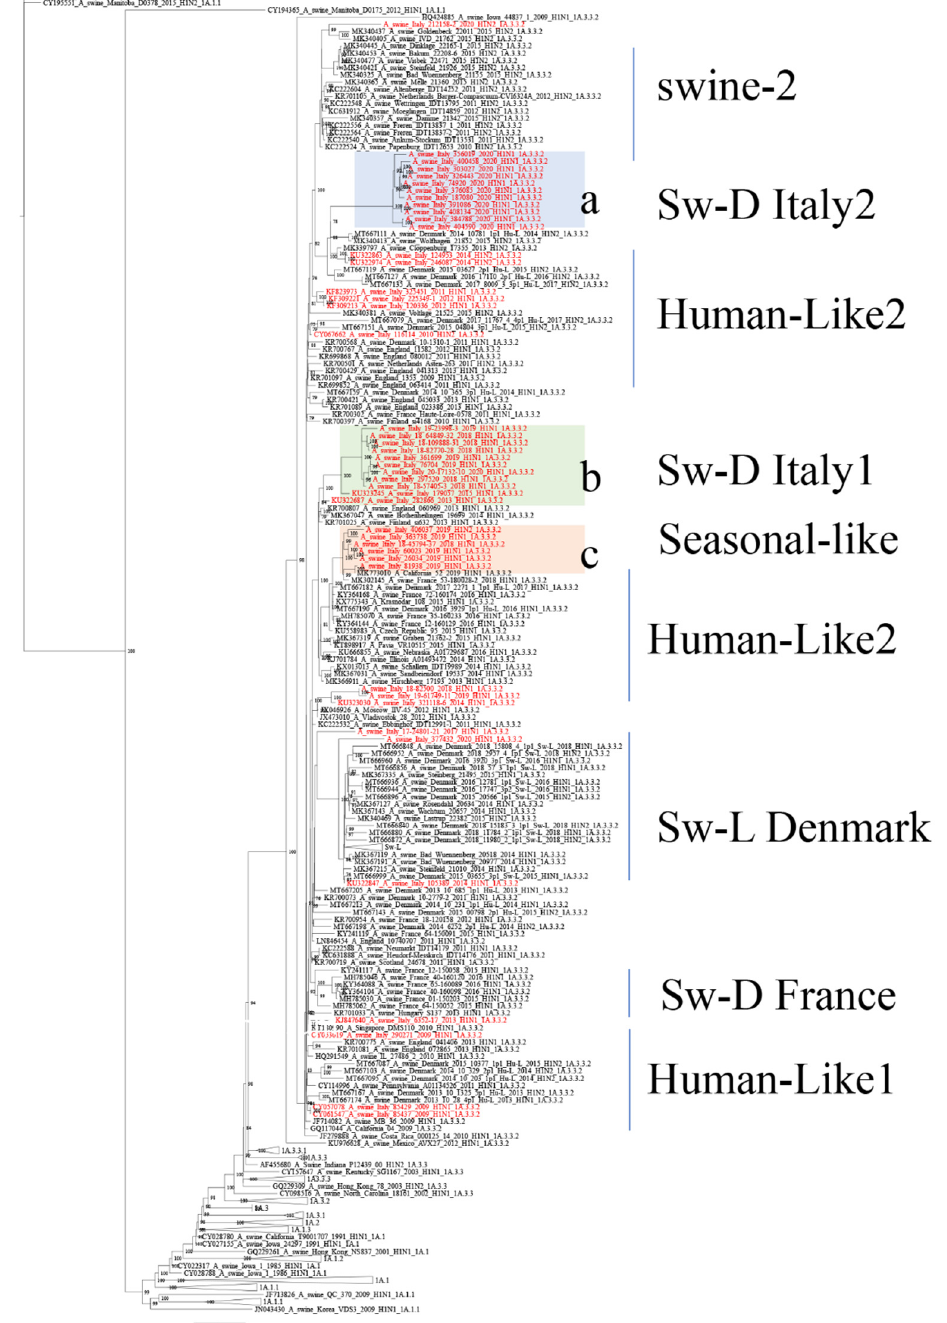
Figure 3. ML phylogenetic tree of 270 HA-H1A with the 29 HA-1A, 1A.3.3.2, sequences (1611 nucleotides) of strains analyzed in this work. Tree is inferred with European reference sequences retrieved from Genbank collected in the years 2009–2020 with the reference sequences used to construct the global swine H1 clade classification reference tree, which is used to classify the clade of the HA/H1 viruses [8]. The three main sub-clusters circulating recently in the country ( a – c ) are highlighted in light blue, green, and pink, respectively and the closest HA sequences matching strains in sub-clusters a, b and c are included. Italian sequences are in red;. Bootstrap values under 70% are not shown; scale bar represents number of nucleotide substitutions per nucleotide site. Sequences retrieved from Genbank are identified by their accession number. Clusters are named according to recent papers describing swIAVs in Europe [6,9,18].